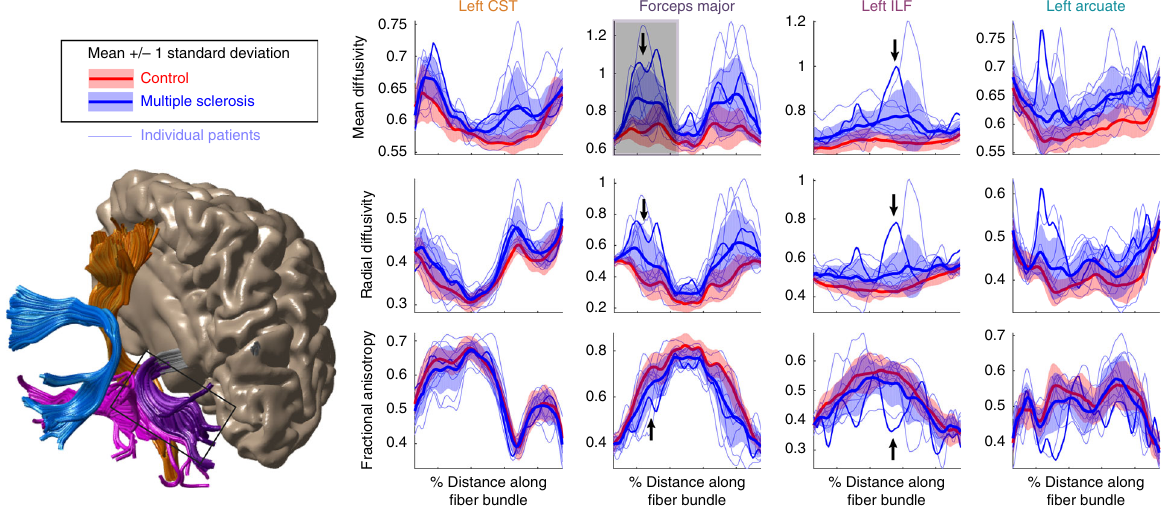
Fig. 3 Localizing lesions in an individual ’ s brain. Individual MS patients (light blue lines) are plotted against the normal distribution (mean + /- 1 standard deviation) of values in healthy control subjects. Lesions and diffuse abnormalities can be detected in individuals based on large deviations from the control subjects. The darker blue line is data from the patient shown in Figure 8 of Yeatman et al. 19 . By plotting standard deviations rather than standard errors, the large (>1 SD) difference between MS patients and control subjects is apparent, as are the large deviations of speci fi c patients from the normal distribution (see Figure3_4_MultipleSclerosis.m and https://YeatmanLab.github.io/AFQ-Browser-MSexample/)